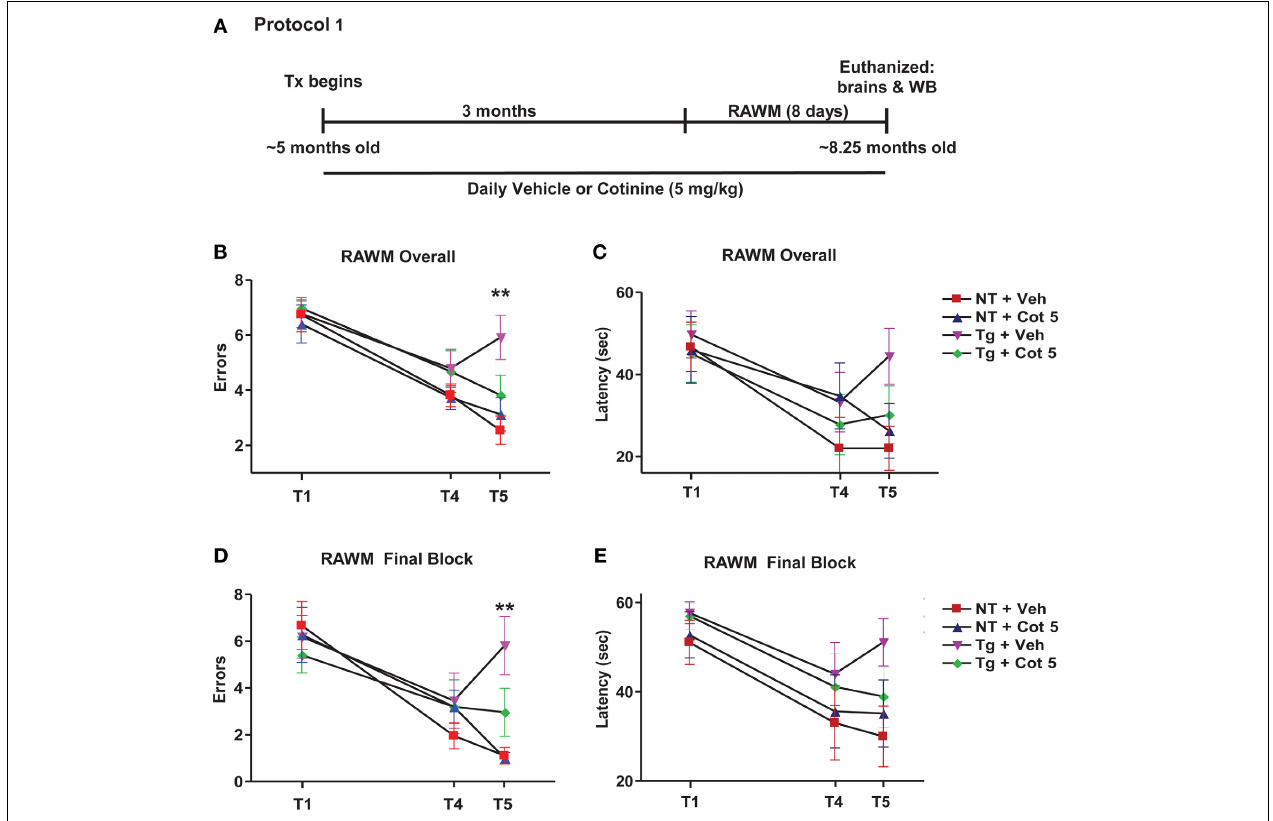
FIGURE 1 | Cotinine prevented cognitive impairment in Tg6799 mice. 4.5–5 month-old mice ( n = 8 per group) were treated daily for 3 months and tested in the radial arm water maze (RAWM; A ). Chronic cotinine treatment (5mg/kg) diminished cognitive impairment in the transgenic (Tg) mice as assessed using the RAWM testing for working memory. This tests revealed